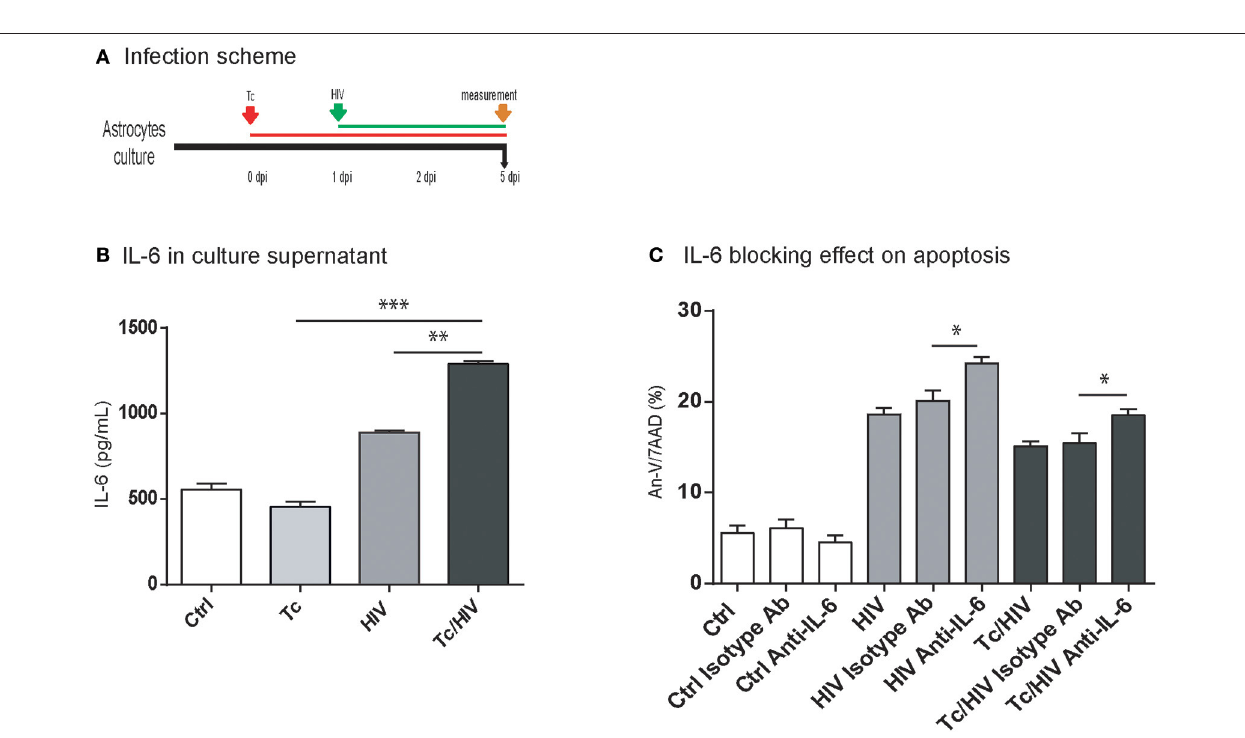
FIGURE 3 | IL-6 level according to infection status and effect of IL-6 blocking assay on apoptosis. (A) Infection timeline. (B) IL-6 levels were evaluated in culture supernatant by ELISA at 5 dpi for each condition. (C) Flow cytometric apoptosis assay (Annexin V/7AAD) on astrocytes upon exposure to Tc, HIV, or combination (Tc/HIV). For each condition is also shown the IL-6 blocking assay. IgG1 isotype controls (“isotype Ab”) were included for each condition. Percentage of apoptotic cells at 5 dpi is shown. Mean values ± SD from three different experiments. Statistical significance for each condition vs. pathogen unexposed control, or